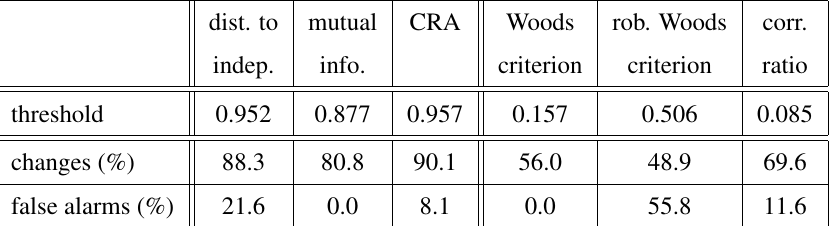
Table 5. Panchromatic/HS pair: change and false alarm estimates based on mean change measure thresholds. dist. to mutual CRA Woods corr. indep. info. criterion criterion